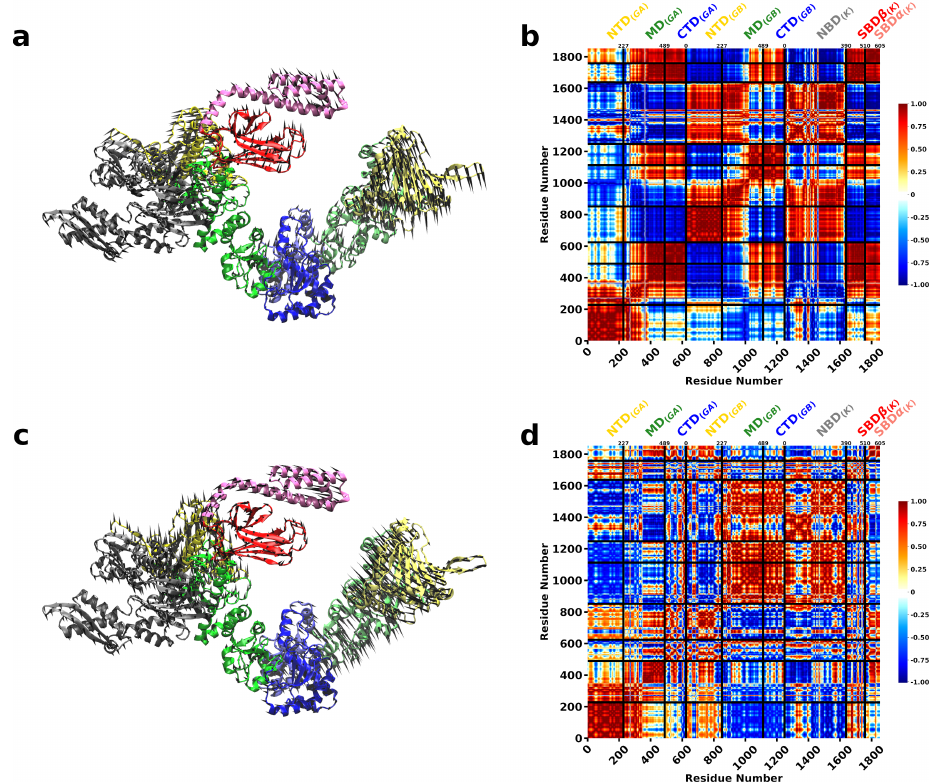
Figure 5. Motions associated with significant normal modes of Hsp90 Ec when one DnaK is bound. ( a ) Mode 8 involves a scissoring motion about the CTD domains of Hsp90 Ec with DnaK undergoing torsional motions perpendicular to the protomer of Hsp90 Ec which it is bound. The DnaK SBD is placed into the client binding site of Hsp90 Ec ( b ) Covariance matrix of amino acid pairs for Mode 8 ( c ) Mode 10 is a torsional motion of Hsp90 Ec about the CTD dimerization domain with DnaK undergoing torsions about the same axis as Hsp90 Ec . ( d ) Covariance matrix of amino acid pairs for modes 10. The DnaK SBD- α and SBD- β open to potentially release a client. Arrows in ( a , c ) indicate the amplitude and direction of motions of amino acids in each mode. The NBD of DnaK is colored in grey with the SBD- α in mauve and the SBD- β in red. Correlated movements in covariance matricies ( b , d ) are highlighted in red while anticorrelated movements are represented in